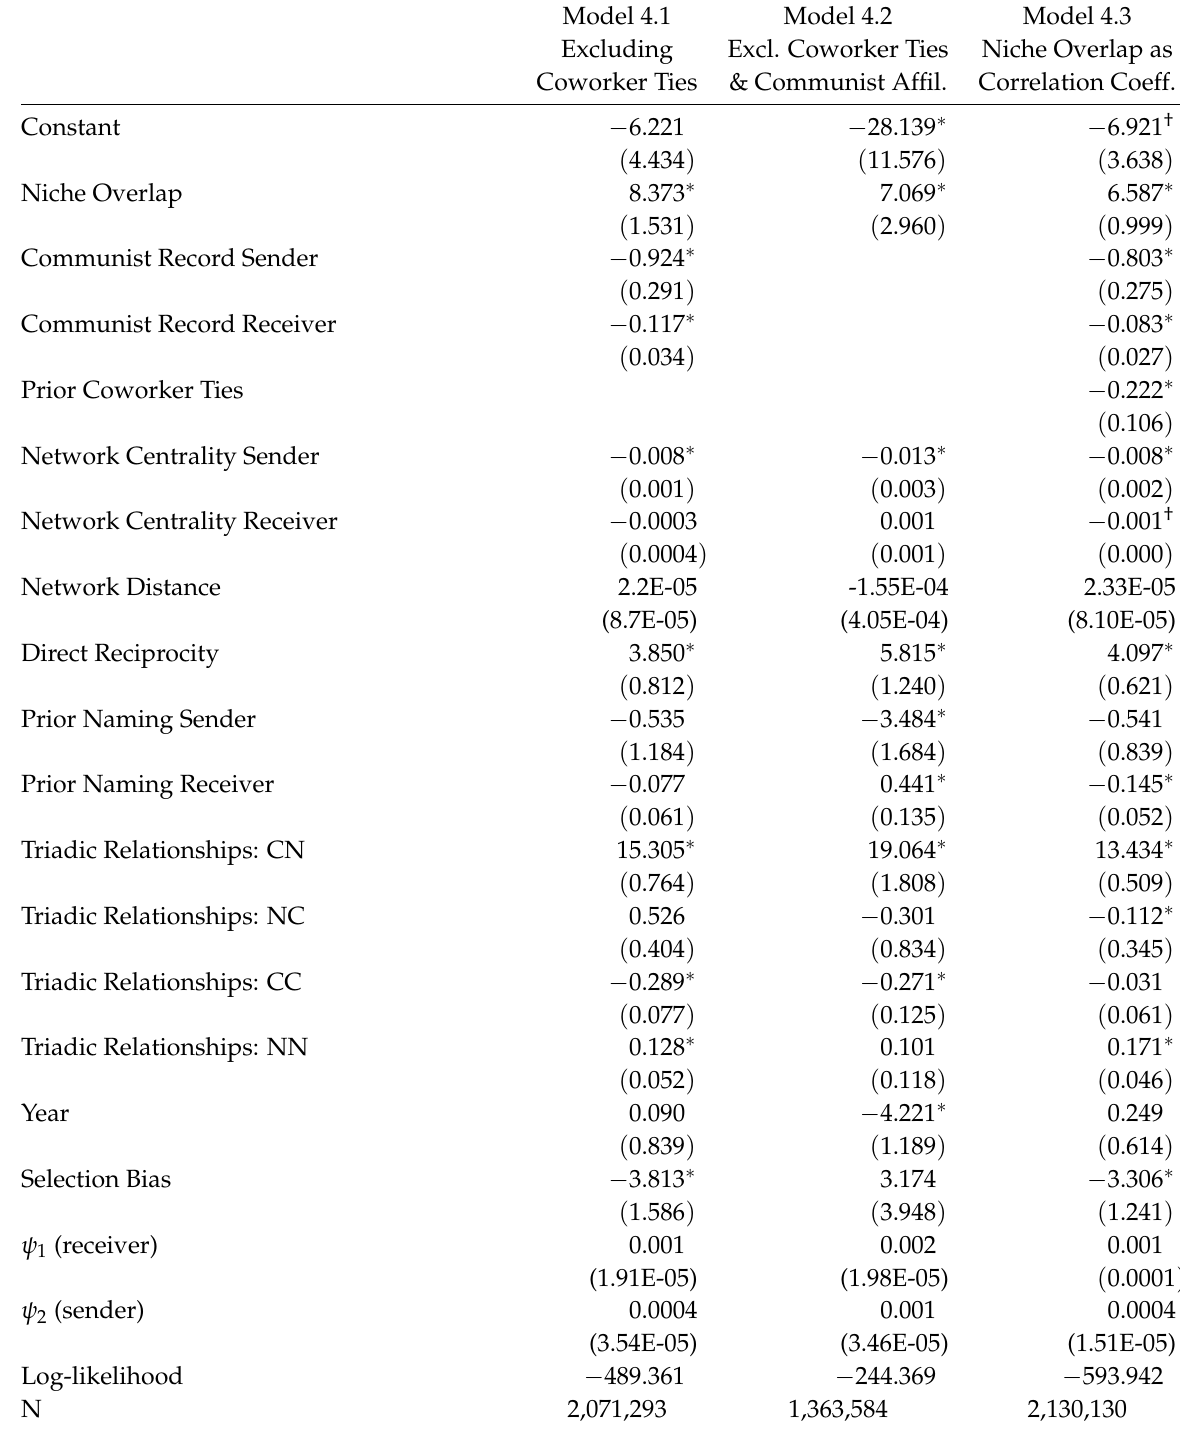
Table 4: Maximum-Likelihood Estimates of Informing during the HUAC Hearings — Robustness Tests (Cross Random-Effects Logistic